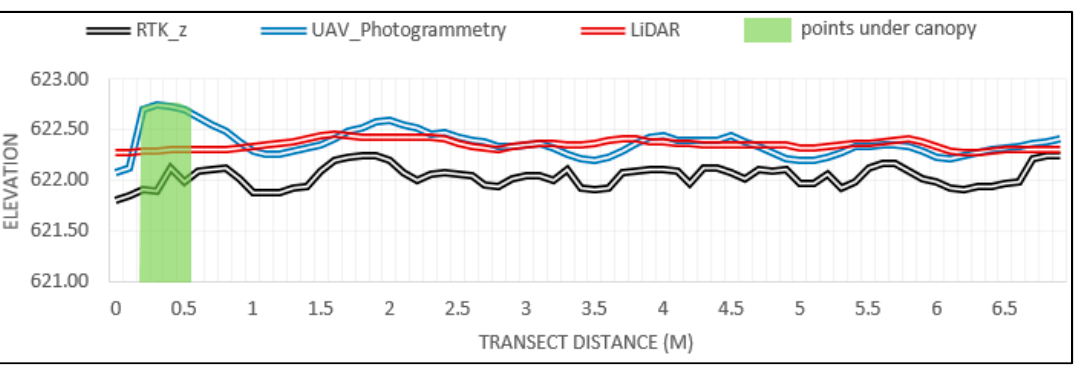
Figure 4. A comparison of dataset performance along a detailed transect within an undisturbed portion of the study site (representing a mixture of Classes 2 and 3). Both UAV photogrammetry and LiDAR overestimate ‘true’ ground-surface elevation, represented in black, though UAV photogrammetry is better-able to capture microtopographic variability. The area in green indicates ground points that were fully covered by vegetation canopy.